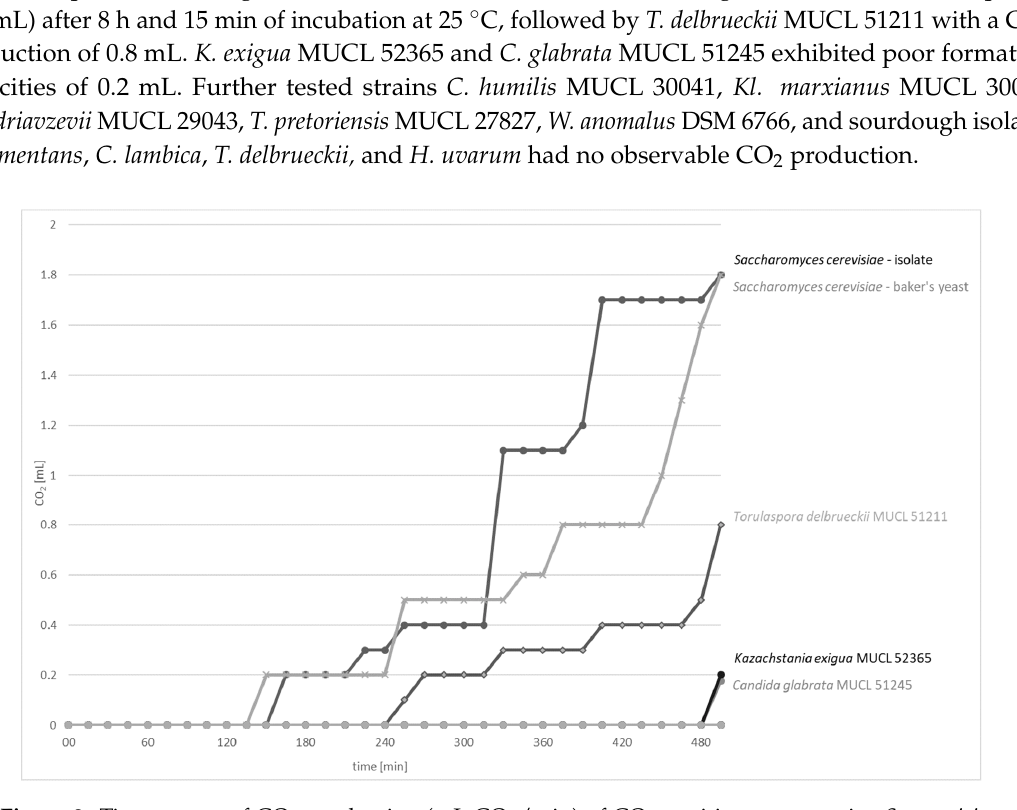
Figure 2. Time course of CO 2 production (mL CO 2 /min) of CO 2 -positive yeast strains S. cerevisiae , T. delbrueckii MUCL 51211, K. exigua MUCL 52365, and C. glabrata MUCL 51245 over 8 h and 15 min of incubation at 25 °C.